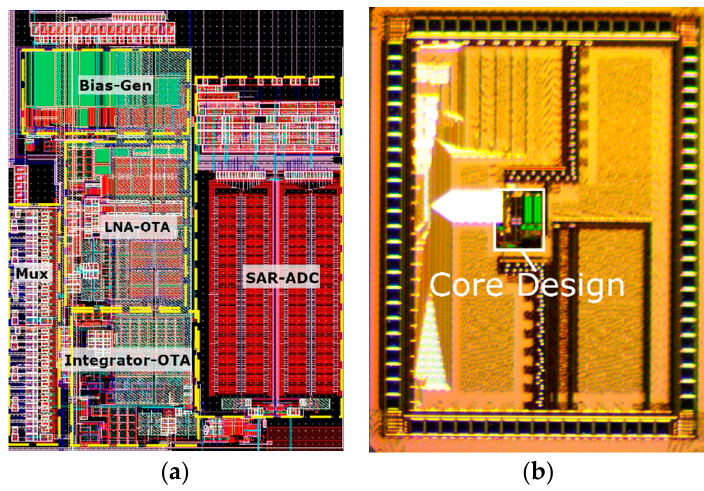
Figure 10. ( a ) Layout of the core circuitry of the fabricated CMOS design; ( b ) micrograph of the fabricated test chip, with core circuitry highlighted in the center.